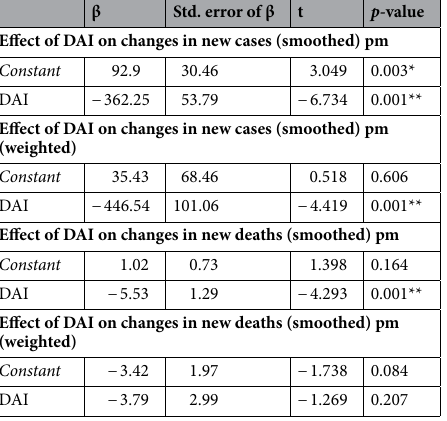
Table 1. Linear regression analyses of the association between DAI and changes in COVID-19 new cases and deaths months after their peaks. * p ≤ 0.05; ** p ≤ 0.001. The regression coefficient (β) is the degree of change in the outcome variable for every one-unit change in the predictor variable. The t-statistic is the regression coefficient divided by its standard error. Digital adoption is expressed in arbitrary units of